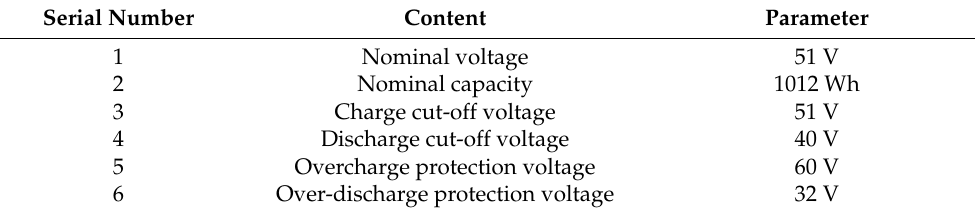
Table 2. The electrical performance indexes of the battery pack.